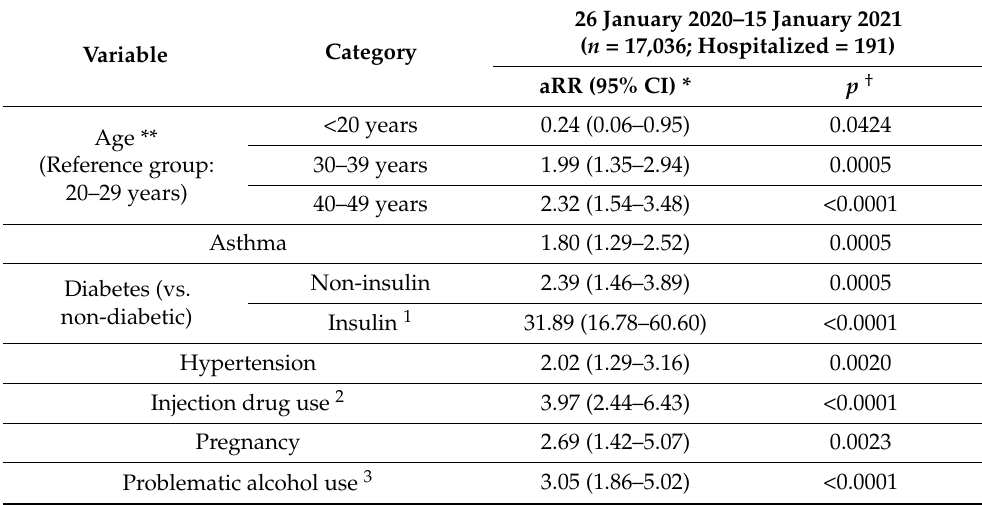
Figure 1. Multivariable model for factors associated with COVID-19–related hospitalization in British Columbia. Table 3. Factors associated with hospitalization status in multivariable Poisson regression analysis with robust error variance among women of reproductive age (15–49 years-old), BC COVID-19 Cohort ‡